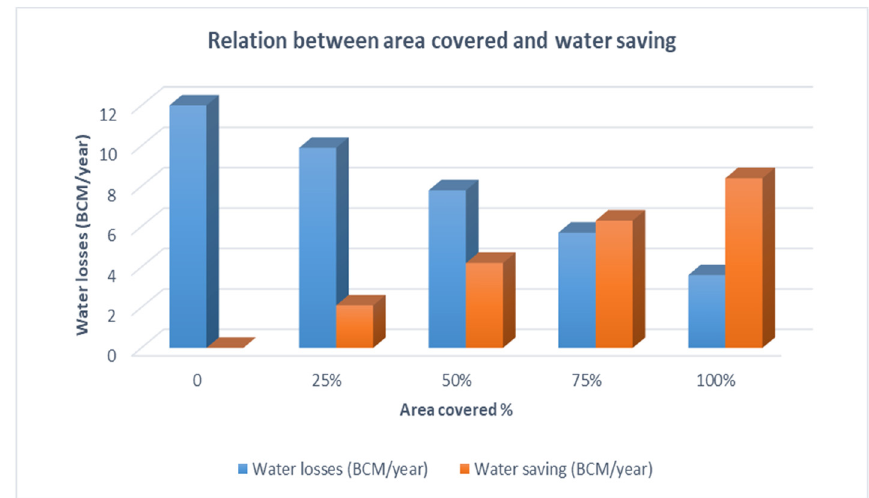
Figure 7. Monthly water losses after using an FPVS at Lake Nasser.